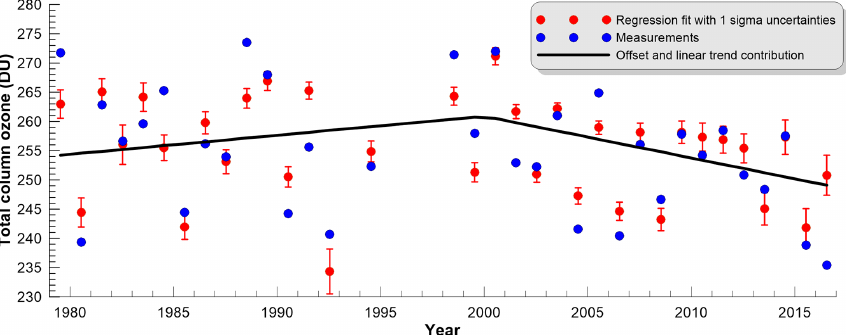
Figure 19. The July mean total column ozone at 19.5 ◦ S, 164.375 ◦ W (blue dots) together with the regression model values (red dots) and their 1 σ uncertainties, and the contribution to the regression model from the offset and two trend basis